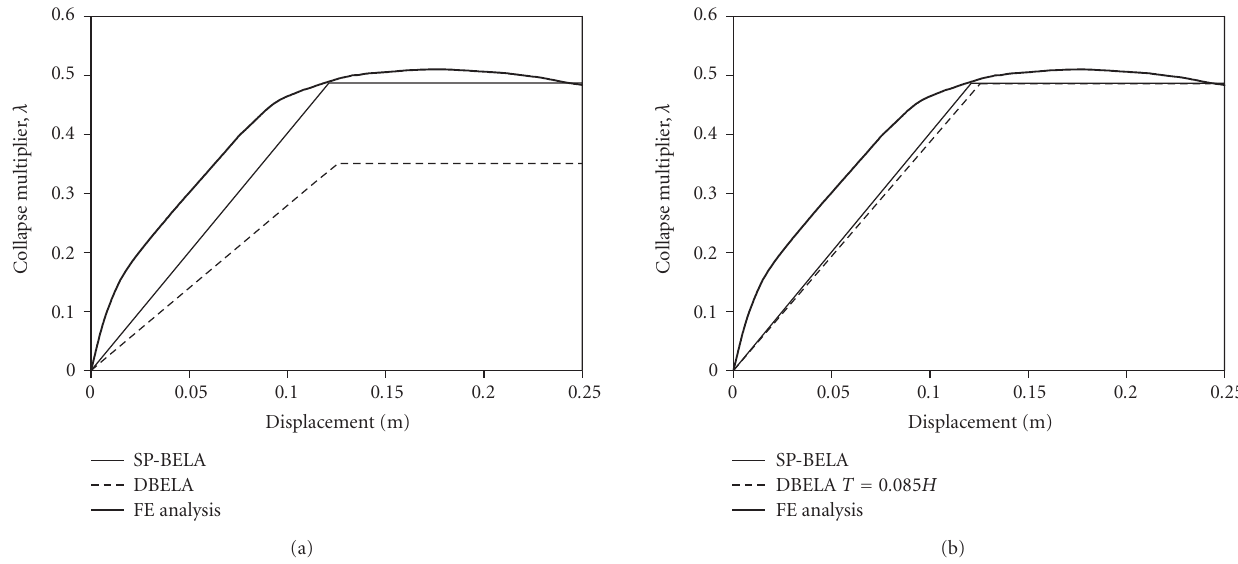
Figure 6: Comparison of pushover analyses for seismically designed building, c = 7 . 5%, (a) original period-height relationship in DBELA (b) modified period-height relationship in DBELA.